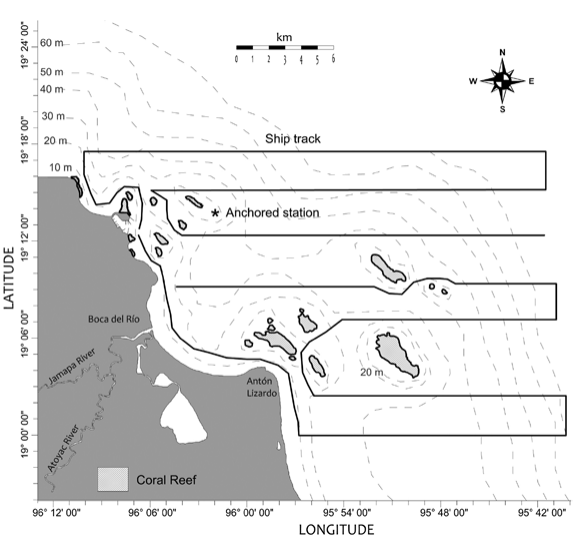
Fig. 1. – The bathymetry of the Veracruz Reef System is represented with dashed lines, the ship track of both vessel-mounted ADCPs are represented with a solid black line, the anchored station is represent- ed with an asterisk and the four ADP locations in the southeastern coral reef area are represented with numbers